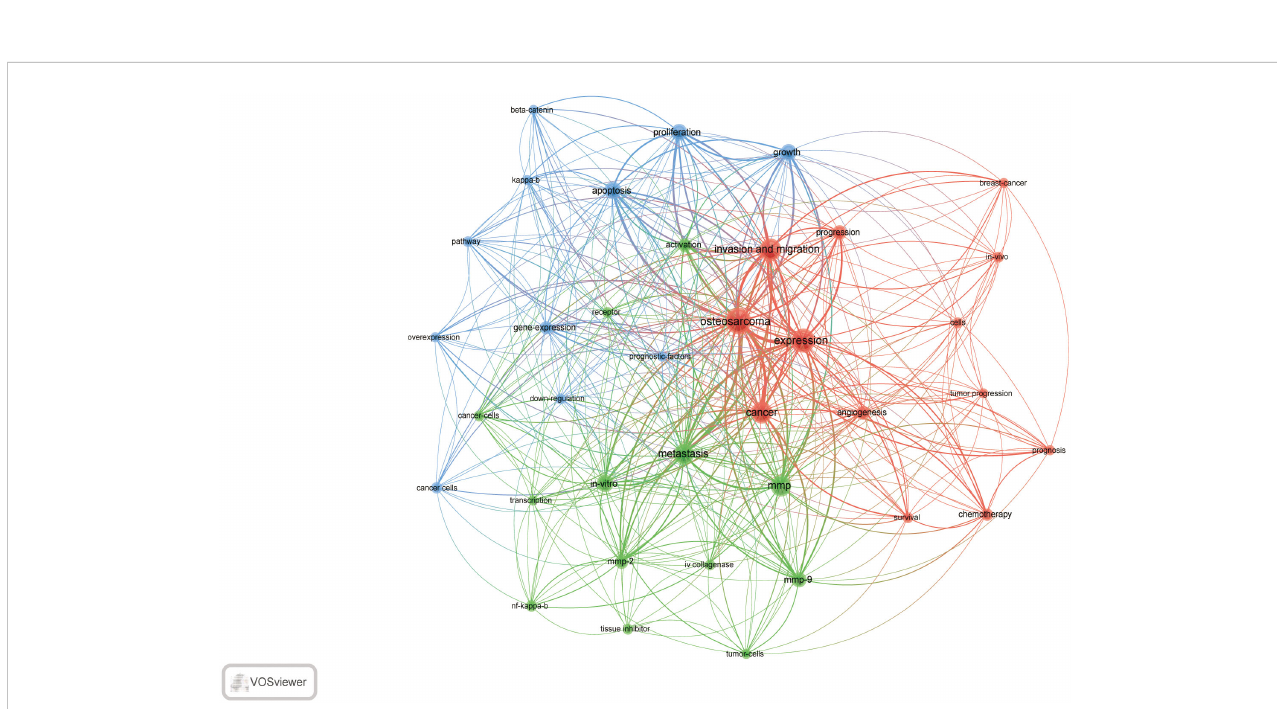
FIGURE 13 keyword co-occurrence network and clusters in MMP-OS research (T ≥ 2, contains 37 items, 3 clusters and 788 links; maxlines = 1000.). The size of node and word re fl ects the co-occurrence frequencies, the link indicate the co-occurrence relationship, and the same color of node represent the same